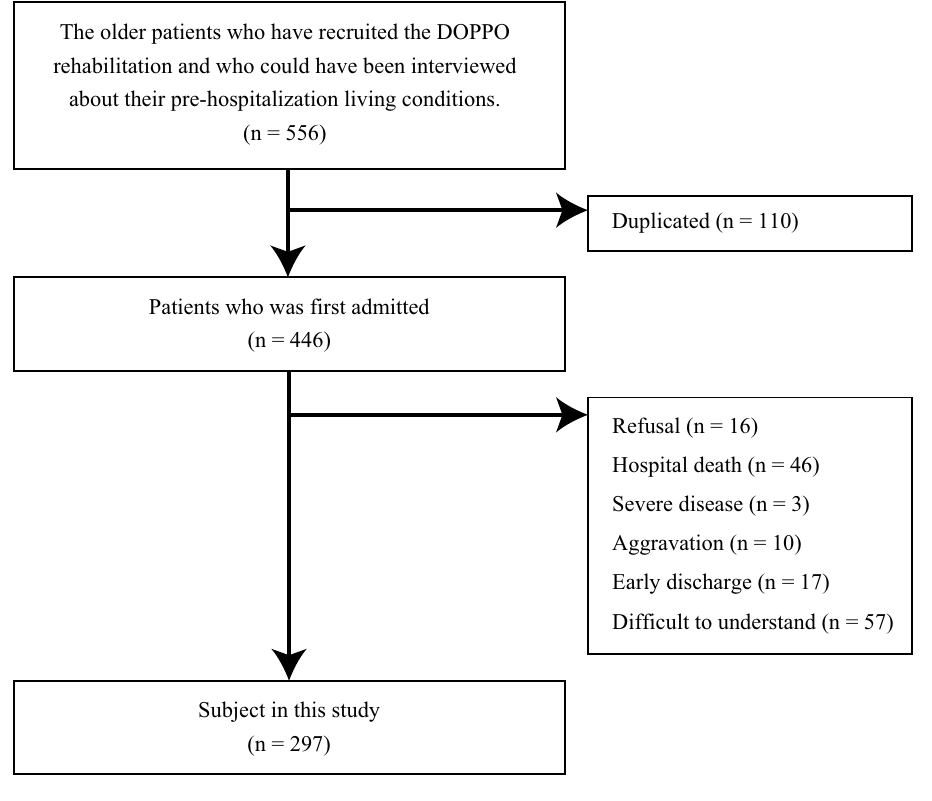
Figure 1. The patients flow in this